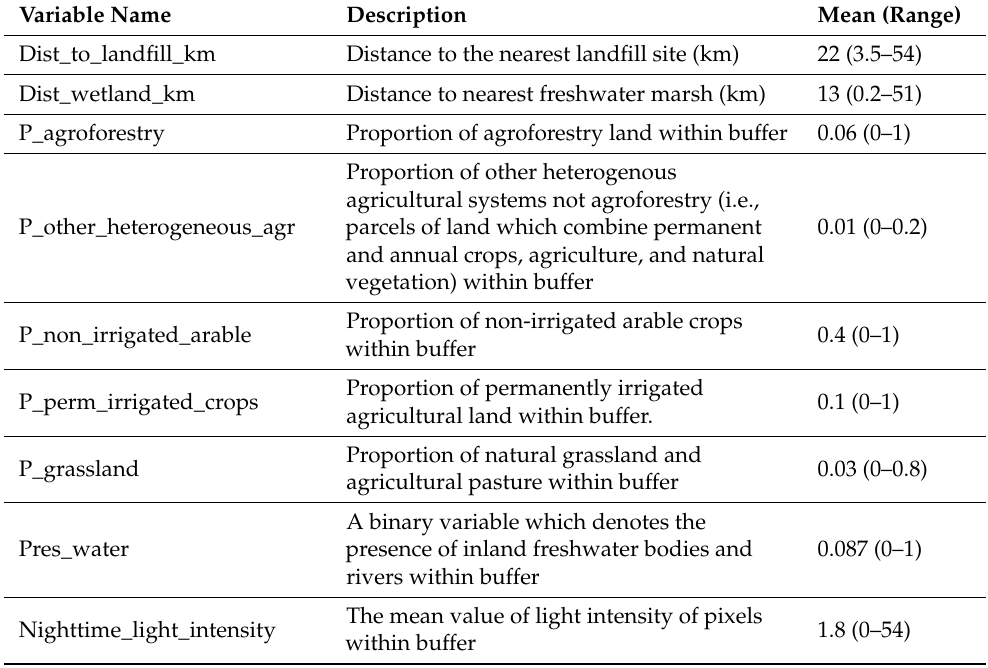
Table 1. List of candidate predictor variables used to model the distribution of white stork ( Ciconia ciconia ) problematic nests on transmission pylons in the Spanish provinces of Huelva and Seville. Mean distances shown here are calculated from the pylon to the nearest boundary of the specified habitat, and habitat proportions represent the relative amount of habitat within 1 km radius buffers centred on the